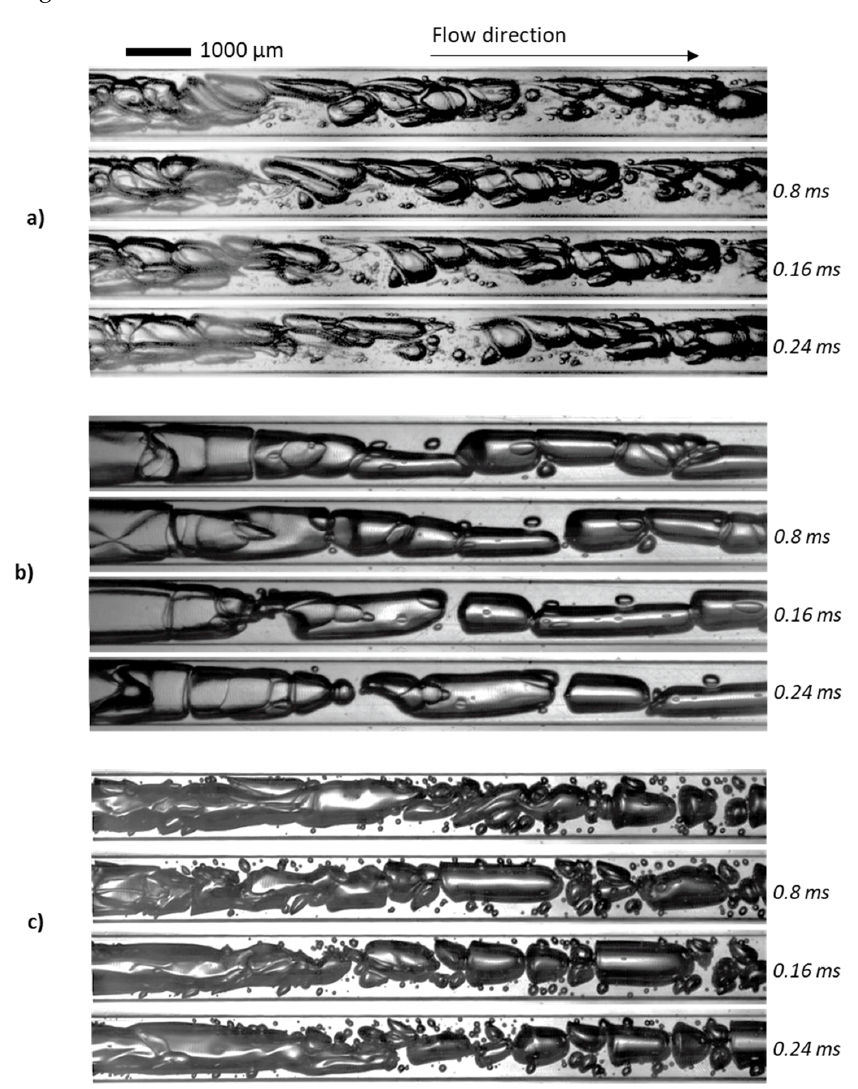
Figure 13. Series of high-speed images selected at an interval of 0.8 ms for the two-phase flow inside the expansion channel of the device CX-E-600. Flowrates used: Q vL = 3 L · h − 1 et Q mG = 5 g · h − 1 . ( a ) WPI3XG04. ( b ) XG04. ( c ) Glycerol 50%. Image acquisition frequency of 5000 images per second, resulting in an interframe time of 0.2